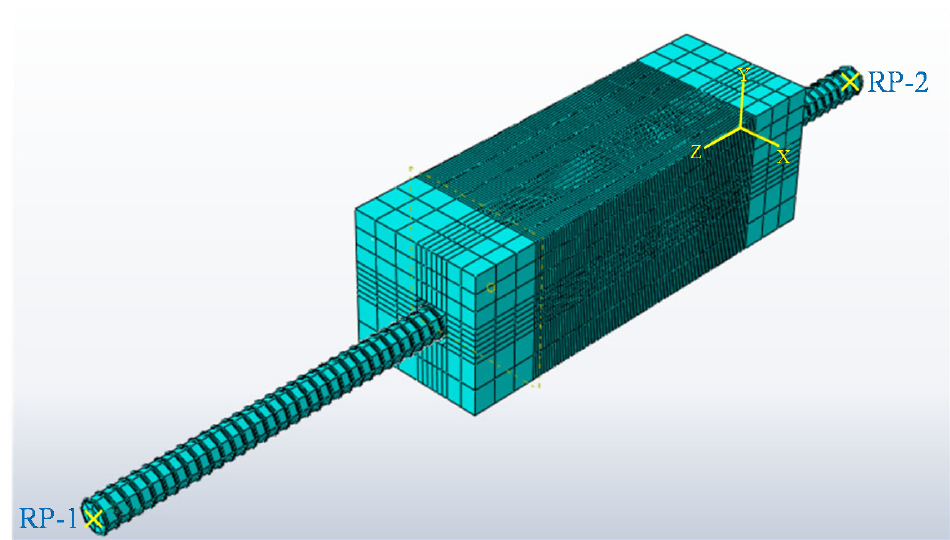
Figure 15. Schematic diagram of three-dimensional model of finite element analysis. Table 11. Comparison of simulation and test